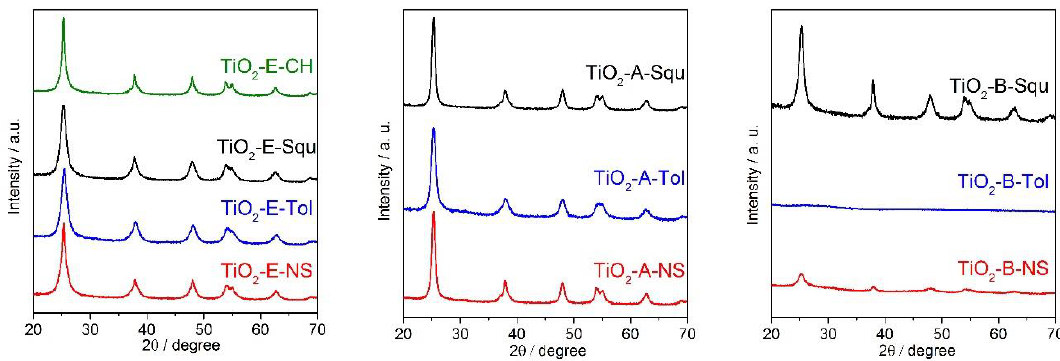
Figure 1. Powder X-ray diffraction (XRD) patterns of non-calcined ( bottom ) and calcined ( top ) TiO 2 samples. Table 2. Crystallite size and textural data for the different TiO 2 samples, before and after calcination.